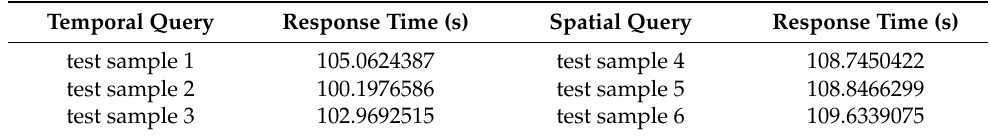
Table 4. stQuery implementation effect of temporal and spatial queries.